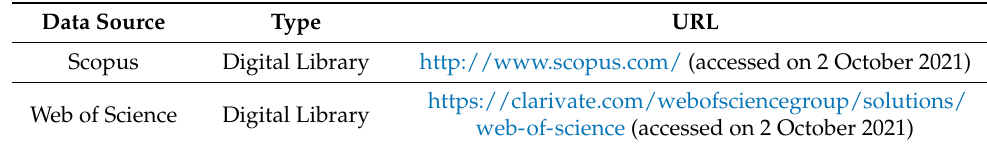
Table 2. Information sources used for the search